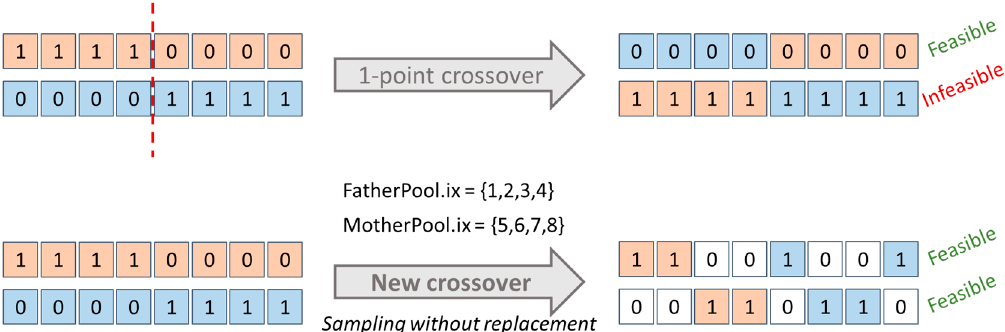
Figure 10. A schematic representation of the new crossover operator.